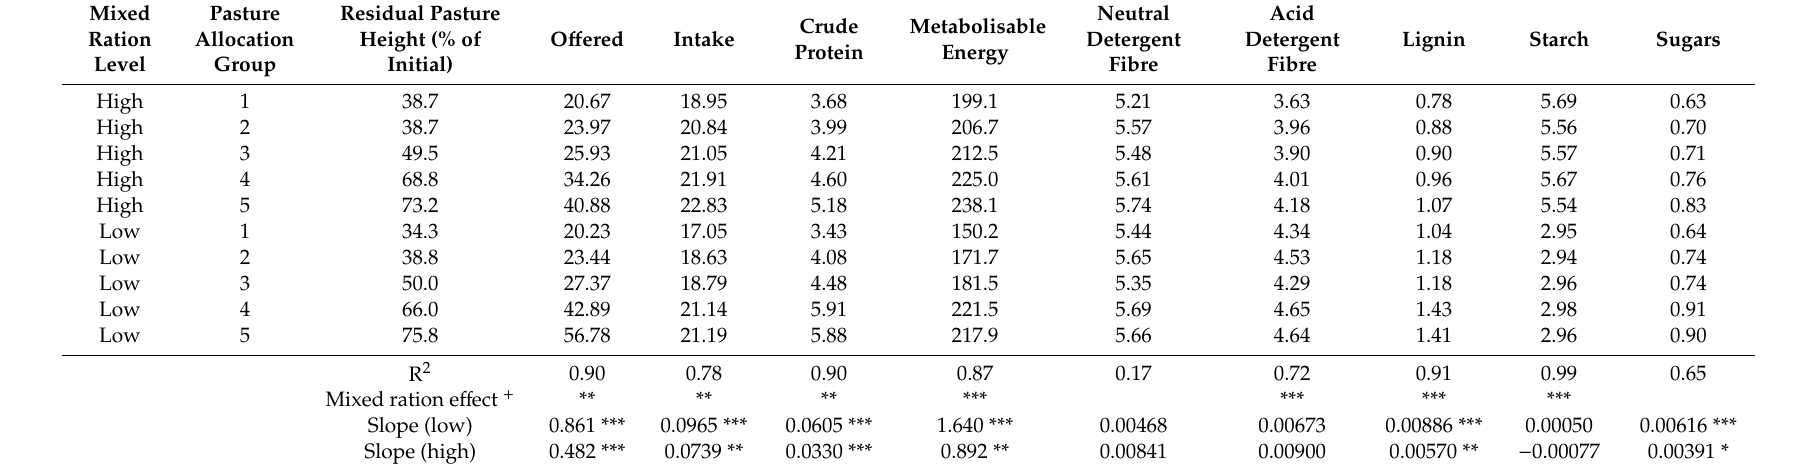
Table 7. The total dry matter (DM) o ff ered and consumed, and nutrient (kg DM / cow / day) and metabolisable energy (MJ / cow / day) intake of the total diet for each treatment